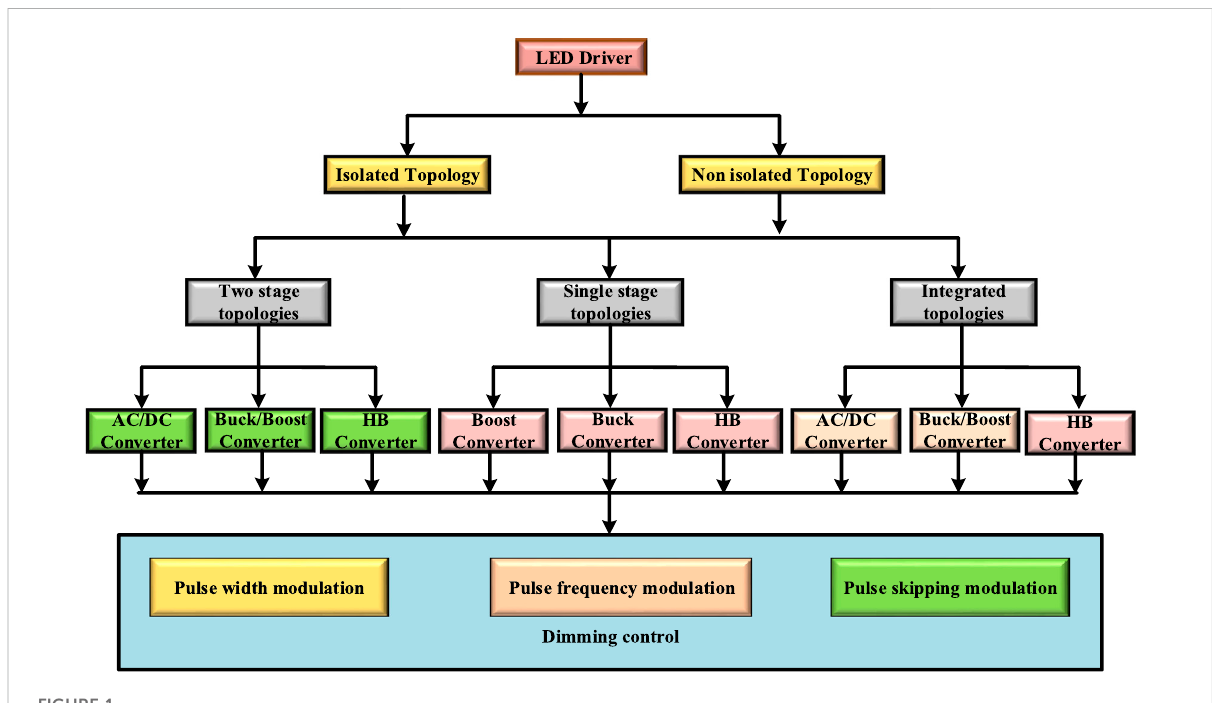
FIGURE 1 General block diagram of various converter topologies and modulation techniques.